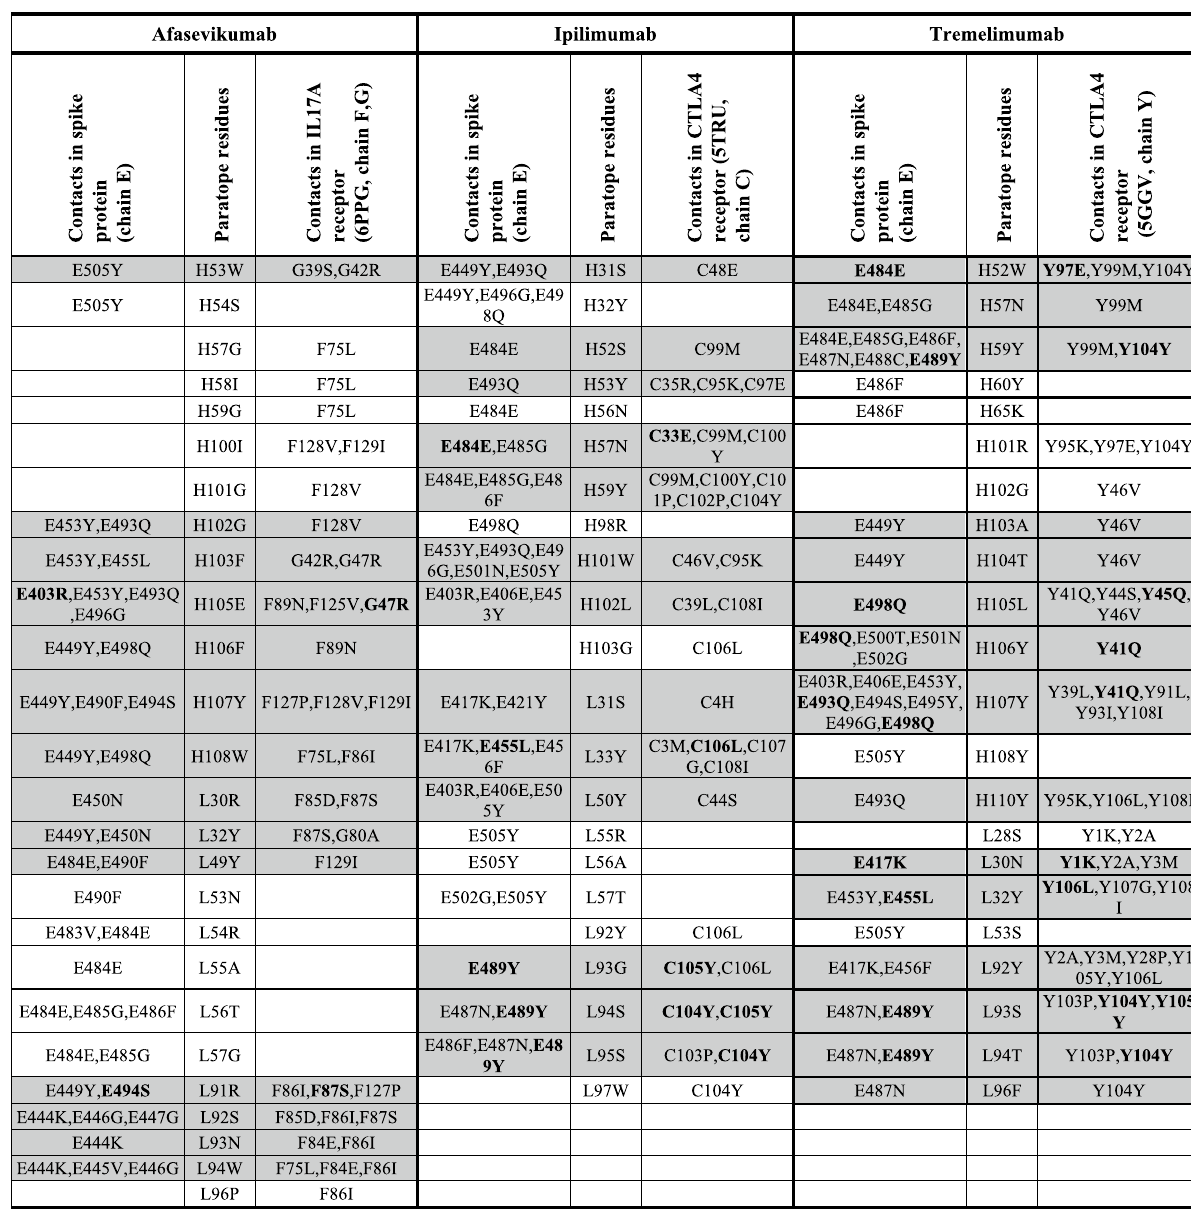
Table 4. Comparison of the contacting amino acid residues of therapeutic antibodies with SARS-CoV-2 spike protein and their respective native target. First letter indicates the polypeptide chain followed by amino acid residue number and notation. Highlighted amino acid residues show the common contacts in spike protein and respective native